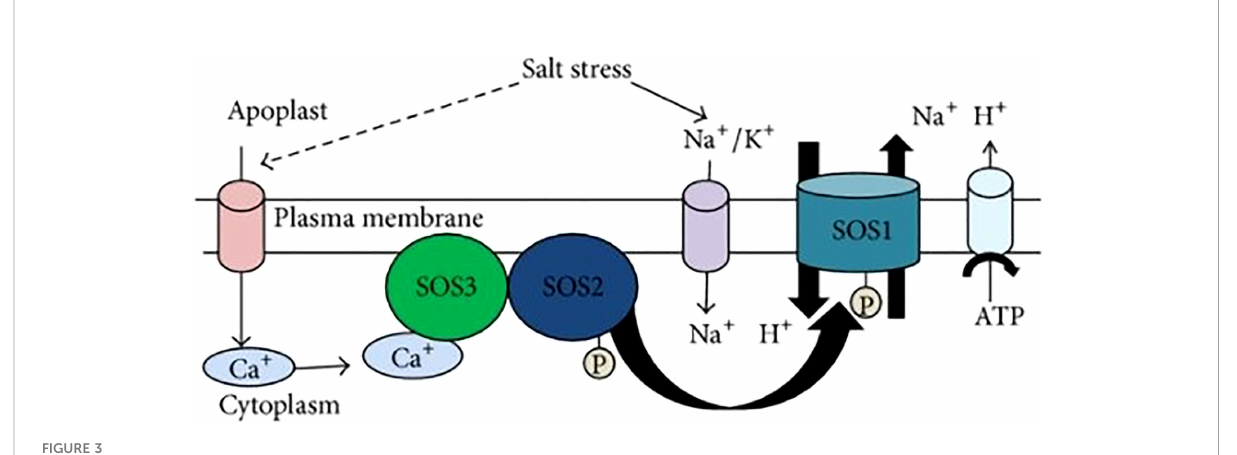
FIGURE 3 SOS Pathway (Gupta and Huang,